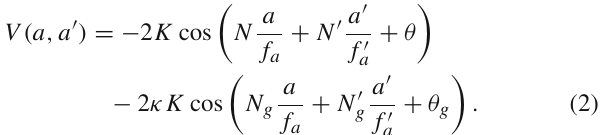
Fig. 1 Photon coupling-mass relation for the two axion mass eigen- states a 1 , 2 . We draw a dashed line to emphasize the connection between thetwoaxionswhichissetbythevalueofthefreeparameter (cid:6) = f a / f (cid:3) a . The lighter axion’s line cuts off at around m 2 ∼ 0.4 meV when its heav- ier companion is excluded by stellar cooling. In gray we display some existing constraints from haloscope searches for DM [9–25], and helio- scope searches for solar axions [26,27]. We stress that these bounds are intended for illustration and context only, and we have not yet recast them into the companion-axion parameter space (see later figures)